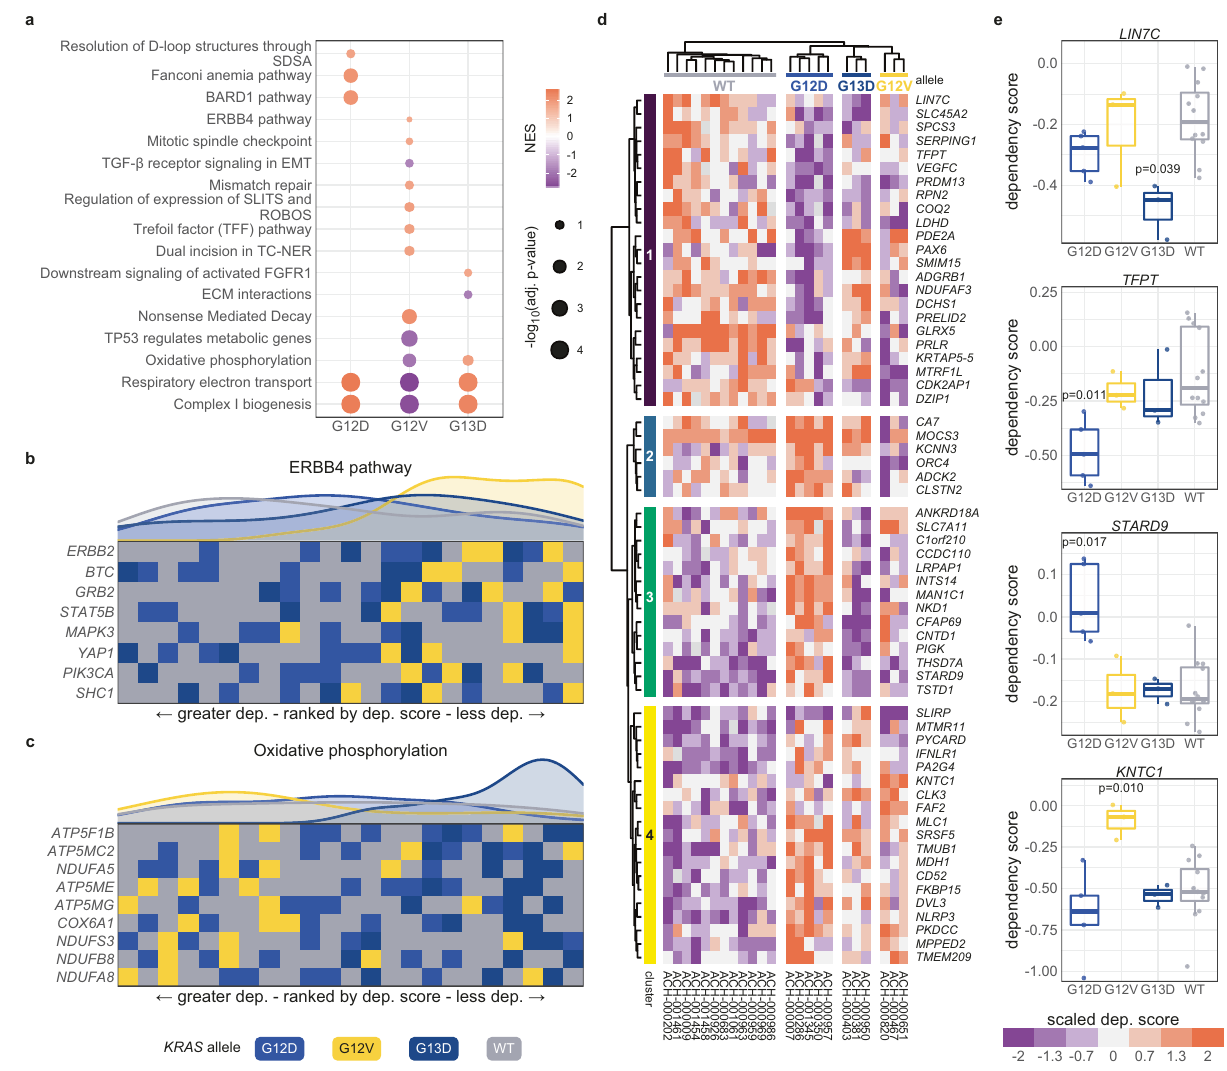
Fig. 4 Allele-speci fi c genetic dependencies in COAD cell lines. a Gene sets with signi fi cant enrichment for increased (lower dependency score; purple) or reduced (higher dependency score; orange) genetic dependency in COAD cell lines. The size of the dot relates the FDR-adjusted p value of the association and the color indicates the strength of the enrichment ( “ normalized enrichment score ” ). b , c Heatmaps ranking the cell lines by dependency ( “ dep. ” ) score of the genes at the leading edge of enrichment for two gene sets. Each row represents a gene and each cell represents a cell line colored by its KRAS allele. The cell lines are arranged in ranking order by their dependency score for the gene. Thus, each column indicates a rank. The line plots above the heatmaps indicate the representation (density) of each KRAS allele at each rank across the genes. d Hierarchically clustered heatmaps of the genes that demonstrated differential genetic dependency amongst cell lines of different KRAS alleles. Each column is a cell line labeled by its DepMap identi fi er and each row is a gene. e Examples of genes that demonstrated differential genetic dependency amongst cell lines of different KRAS alleles ( t tests; FDR- adjusted p values). For the box plots, the box demarcations represent the 25th, 50th, and 75th percentiles, and the whiskers extend from the box to the largest and smallest data points at most 1.5 times the interquartile range away from the median. n = 23 biologically independent COAD cell lines. Source data are provided in the Source data fi dependencies of critical cellular pathways (Supplementary Fig. 9a). For instance, the G12D cell lines demonstrated a reduced dependency on the genes at the G2 and M DNA damage checkpoint (Supplementary Fig. 9b). Moreover, the G12R cell lines were less dependent on PI3K signaling downstream of FGFR1, driven through a reduced dependency on FRS2 ( fi broblast growth factor receptor substrate 2) and GRB2 , which encodes a protein linking EGFR to the GEF SOS1 (Supplementary Fig. 9c). Similarly, the cell lines with KRAS G12V mutations were less sensitive to the knockout of genes implicated in cellular senescence (Supplementary Fig. 9d). This enrichment was driven by a signi fi cantly reduced dependence upon JUN , which encodes